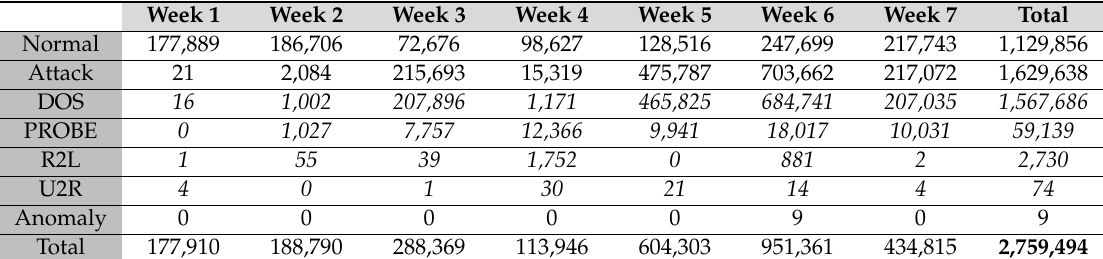
Table 4. Number of connection classes in every file in the gureKDD dataset.